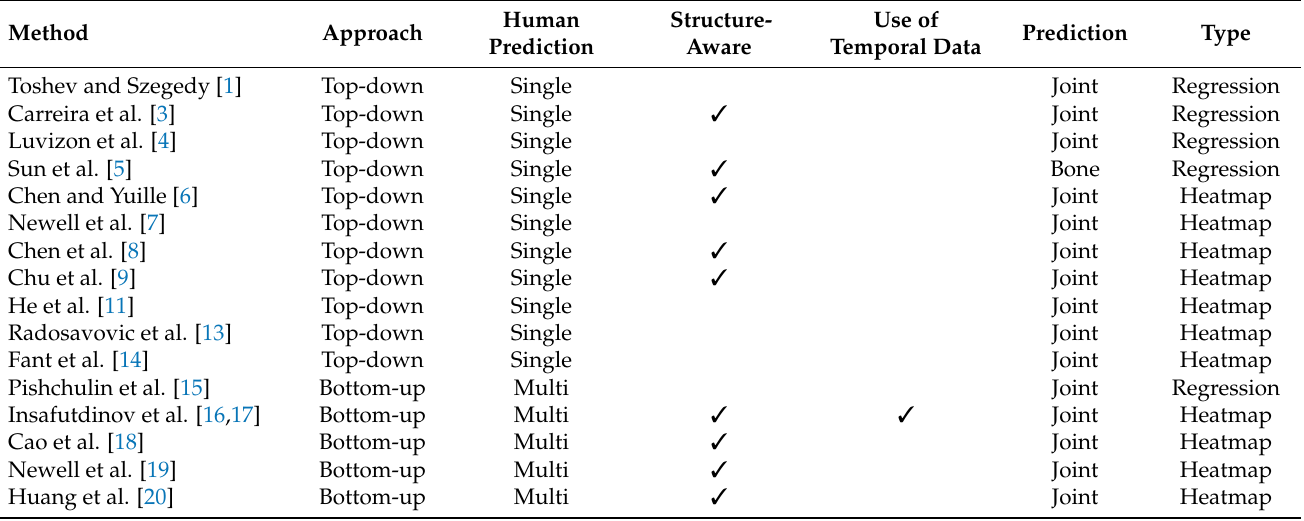
Table 1. Comparison of the key differences between methods for 2D pose estimation. A checkmark in column Structure-aware represents the methods’ ability to ensure the validity of the human skeleton structure. A checkmark in the column Use of temporal data represents whether the method uses previous predictions or other temporal